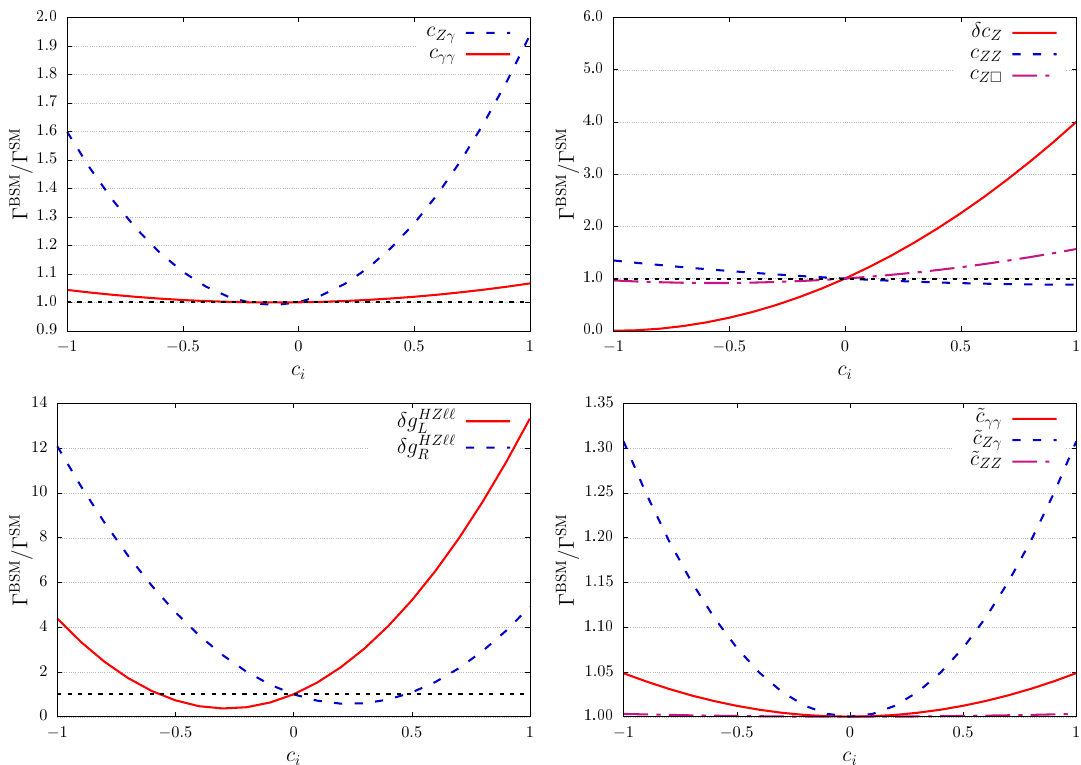
Figure 1. Modi(cid:12)cations of the H 2 e 2 (cid:22) decay width in the presence of Higgs basis parameters. ! In the left plot on the lower line, the coe(cid:14)cients of the contact interactions are taken independent of the anomalous Z‘‘